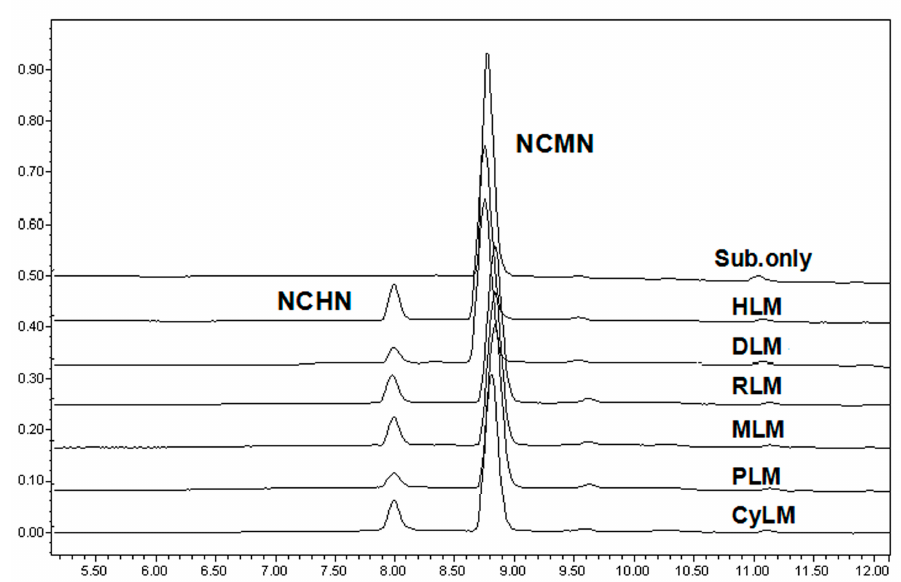
Figure 2. Representative LC-UV profiles of NCMN and its demethylation metabolite in liver microsomes from human, beagle dog, rat, mouse, minipig and cynomolgus monkey. NCMN (10 µM) was incubated with liver microsomes (0.25 mg protein/mL) from each species at 37 °C for 30 min.